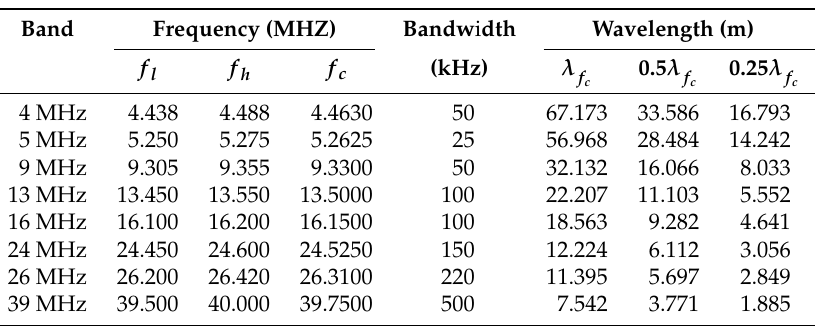
Table 1. Radiodetermination bands designated for oceanographic HFR use within ITU Region 3 (Asia–Pacific Regions). This table is produced from data presented in ITU-R M.2321-0 [41] and shows the associated trend of physical size and some other band related statistics: Lower band limit ( f l )